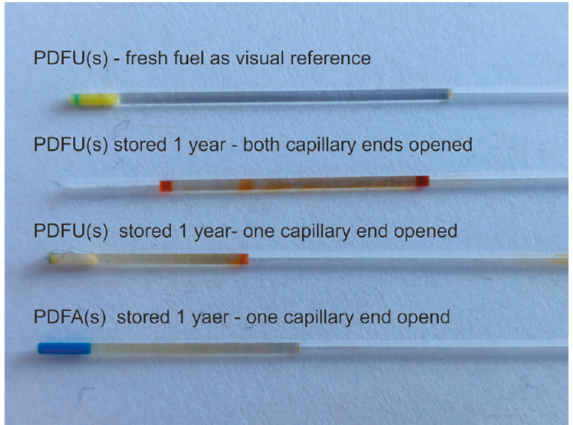
Figure 3. Results of diesel fuels of premium type PDFU(s) and PDFA(s) degradation positioned in a capillary placed at a windowsill for one year.